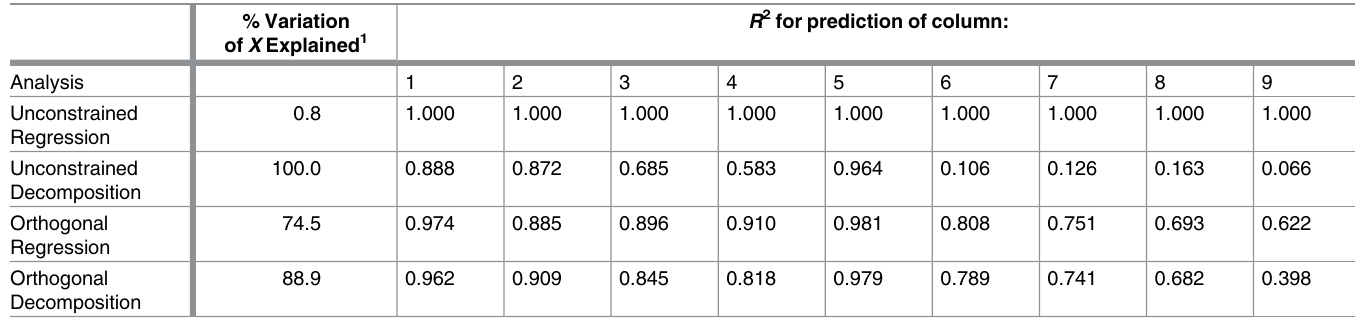
R 2 for prediction of